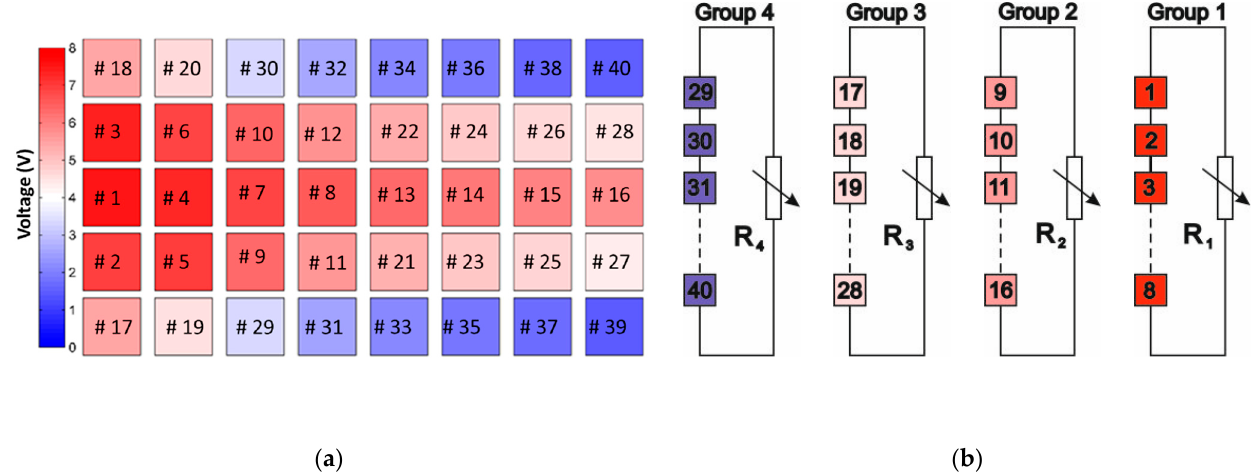
Figure 9. ( a ) Thermoelectric modules are numbered (#1–#40) from hotter to colder and ( b ) diagram of the electrical connection of the TEG modules used in this work.